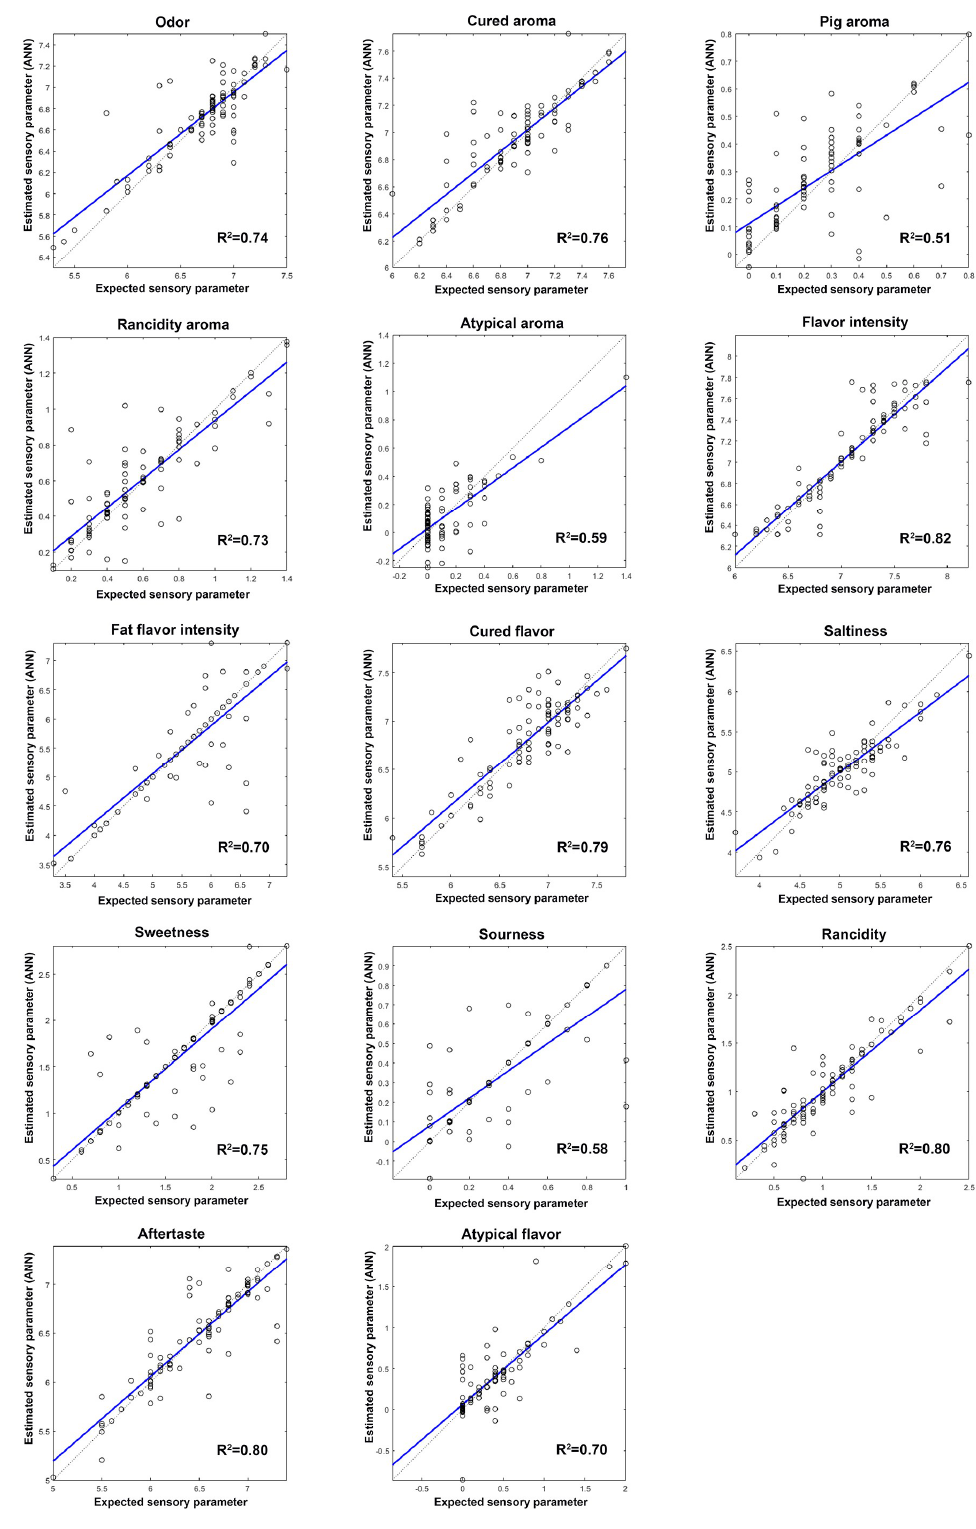
Figure 4. Comparison of the reference values (target) with the values predicted by ANNs for flavor parameters and R